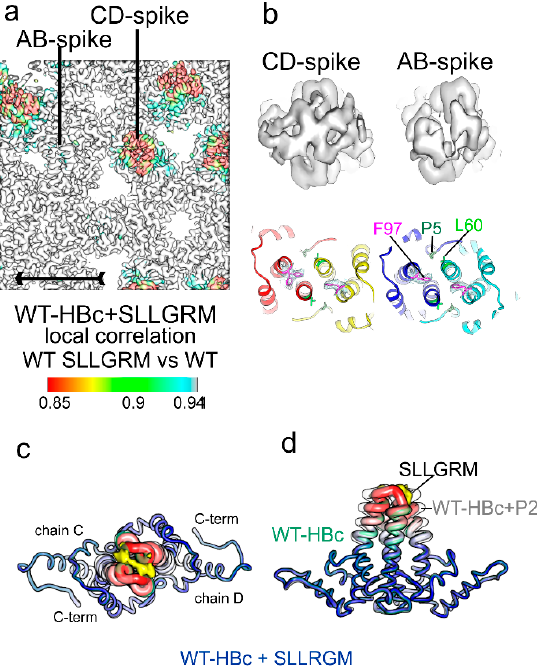
Figure 7. Map and Model of WT-HBc + “SLLGRM”: ( a ) close-up of capsid surface of WT-HBc with bound “SLLGRM” and colored with the local correlation between the maps of WT-HBc +/ − “SLLGRM” (Figure S7). The tips of the CD spikes, but not the AB spikes, differ as indicated by the lower local correlation and seen in the close-ups of the spikes in the upper panel in ( b ); the lower panel in ( b ) shows the models at the center of the spikes with the side chains of P5, L60 and F97 shown in dark green, light green and magenta, respectively. The map density around F97 is shown in mesh representation. In the CD spike, F97 adopts to alternate orientation in chain D; ( c , d ) show chains C and D of WT-HBc + “SLLGRM” superposed with the models of WT-HBc (light green, transparent) and WT-HBc + P2 (white, transparent). The density attributed in the map to “SLLGRM” is shown as surface representation in yellow. WT-HBc + ”SLLGRM” is colored according to its per-residue B-factors (low blue B-factors, high red B-factors). The radius of the tubes in the models relates to the mean displacement calculated from the B-factors. WT-HBc + ”SLLGRM” is more like WT-HBc without bound peptide (light green transparent) than to WT-HBc + P2 (white